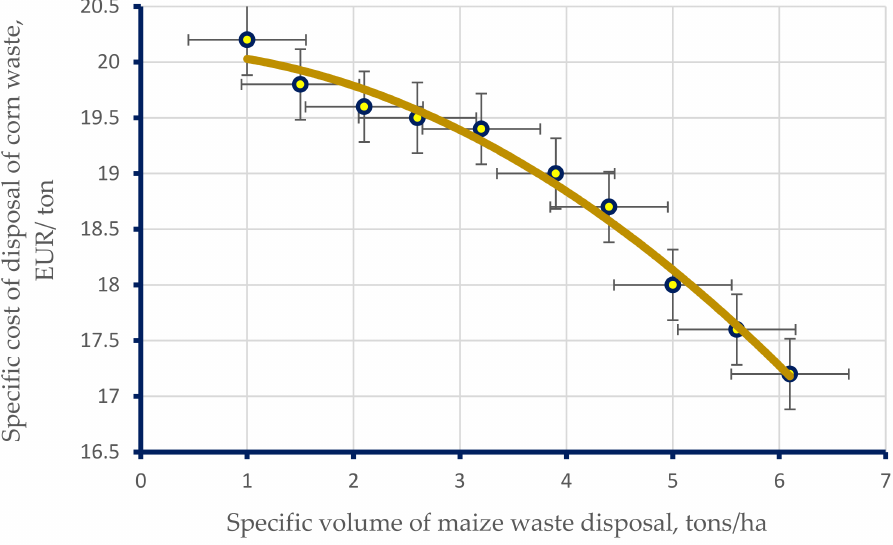
Figure 4. Dependence of the specific cost of alienation of corn waste on its specific volume, provided that the balance of organic carbon in the